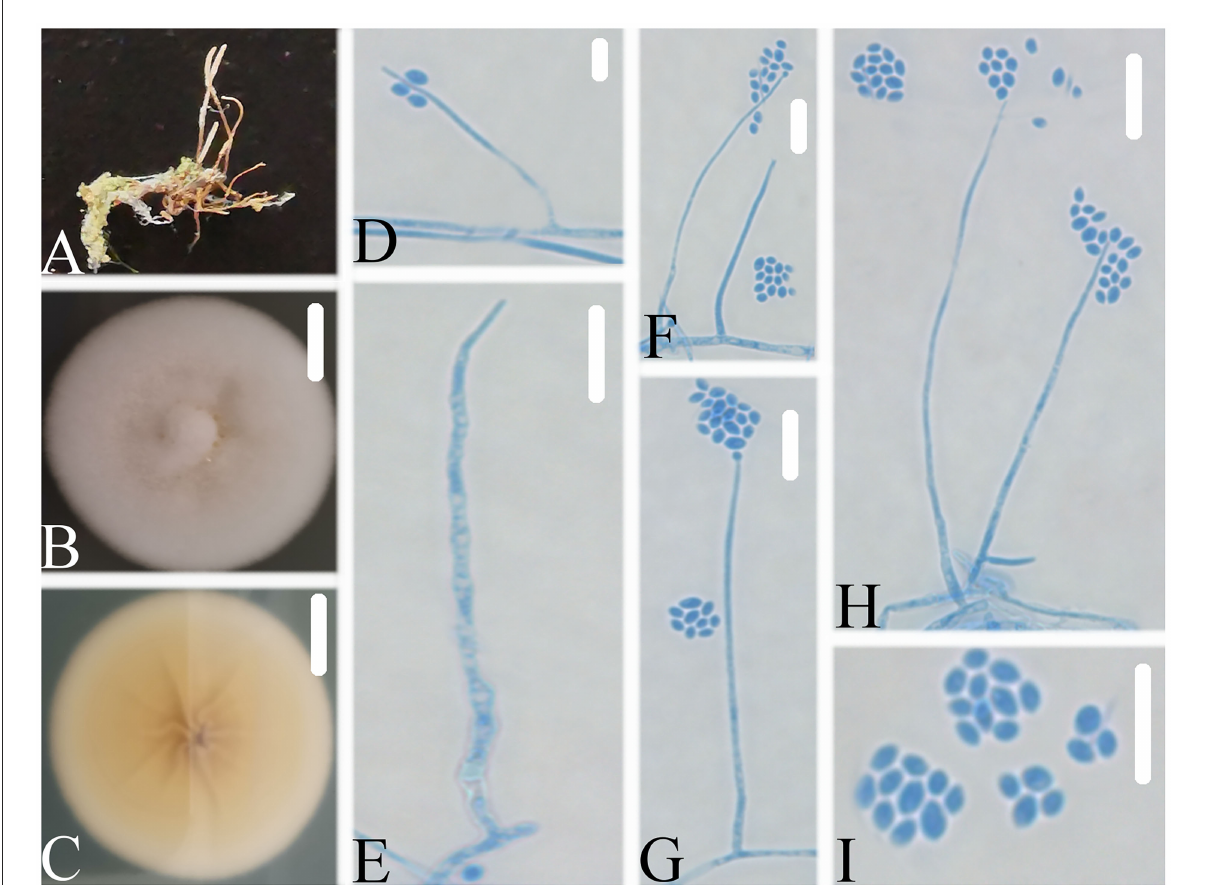
FIGURE6 Simplicillium guizhouense (A) Infected ant (Formicidae); (B,C) PDA-containing culture plate showing the front (B) and reverse (C) sides of the colony; (D–I) solitary phialides and conidia. Scale bars: 10mm (B,C) and 10 µ m (D–I) .